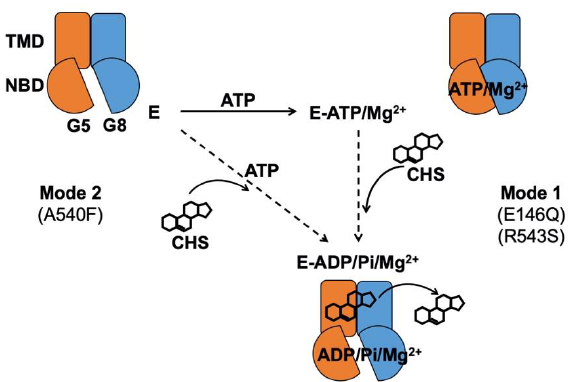
Figure 9. Proposed mechanism of sterol-coupled ATP catalysis by ABCG5 / G8. (Mode 1) A sequential pathway is derived from experiments on the disease mutants, G5-E146Q and G8-R543S. ABCG5 / G8 first recruits ATP and Mg 2 + ions, likely causing a conformational change of the nucleotide-binding domain (NBD) for ATP binding. CHS / sterol then binds the transporter and triggers ATP hydrolysis that may result in its dissociation. (Mode 2) A concerted pathway is derived from experiments on the putative sterol-binding mutant, G5-A540F. ABCG5 / G8 simultaneously recruits CHS, ATP, and Mg 2 + ions, induces a transient conformational change of the NBD, and activates ATP hydrolysis and CHS / sterol dissociation from the transporter. G5: ABCG5; G8: ABCG8; E: ABCG5 / G8 heterodimer; Pi: inorganic